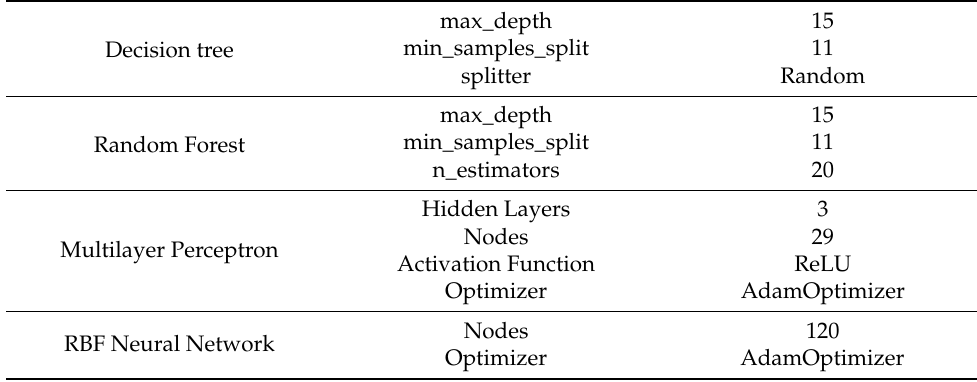
Table 1. Training parameters of the learning